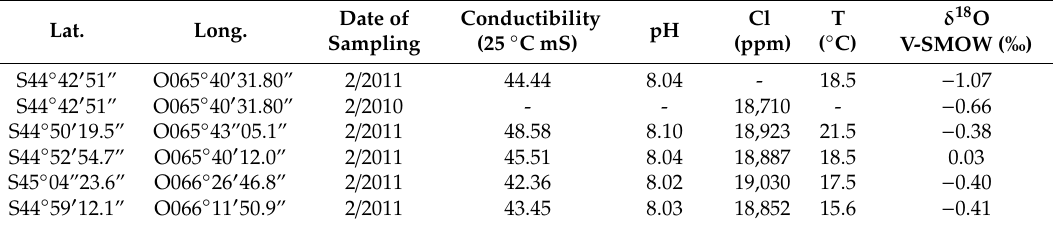
Table 4. Oxygen isotope composition, temperature, salinity and pH of seawater collected along the Camarones coast.